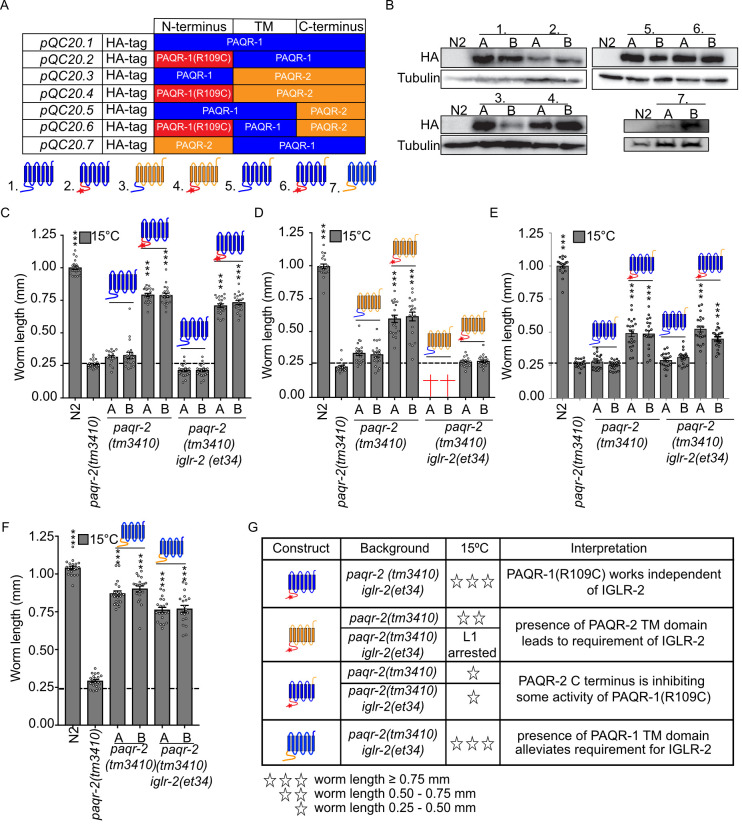
Domain swapping experiments indicate that the intracellular domains of PAQR-2 and IGLR-2 are likely regulatory.(A) Cartoon representation of the constructs used in this structure-function study, all driven by the paqr-2 promoter. (B), Western blots showing expression of the tested constructs; two independent transgenic lines were generated for each construct, labelled A and B. (C-F) Length of worms placed as L1s on NGM media and measured after 144 hours cultivation at 15°C. Note that pQC20.2 is an excellent suppressor of the paqr-2(tm3410) iglr-2(et34) double null mutant (panel C) but that pQC20.4 is not (panel D), which suggests that the transmembrane domains of PAQR-2 require IGLR-2 for activity. Crosses in D indicate likely lethality since it was impossible to obtain a strain with that genotype. (G) Main interpretations from the data in (C-F). The dashed lines in C-F indicate the approximate size of the L1 larvae at the start of the experiment. Significant differences compared to the paqr-2 genotype are indicated where: * p<0.05, **p<0.01 and ***p<0.001 (ns: not significant).